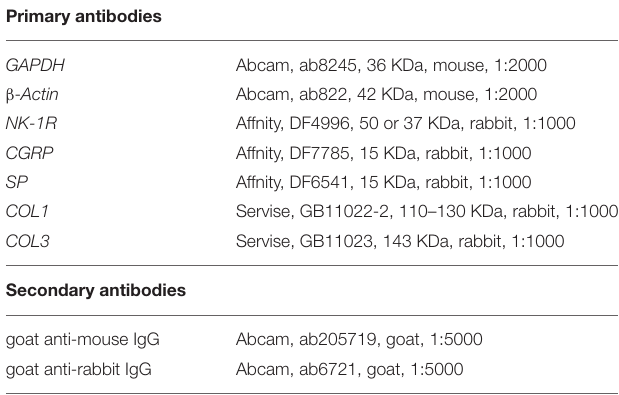
TABLE 1 | List of antibodies.